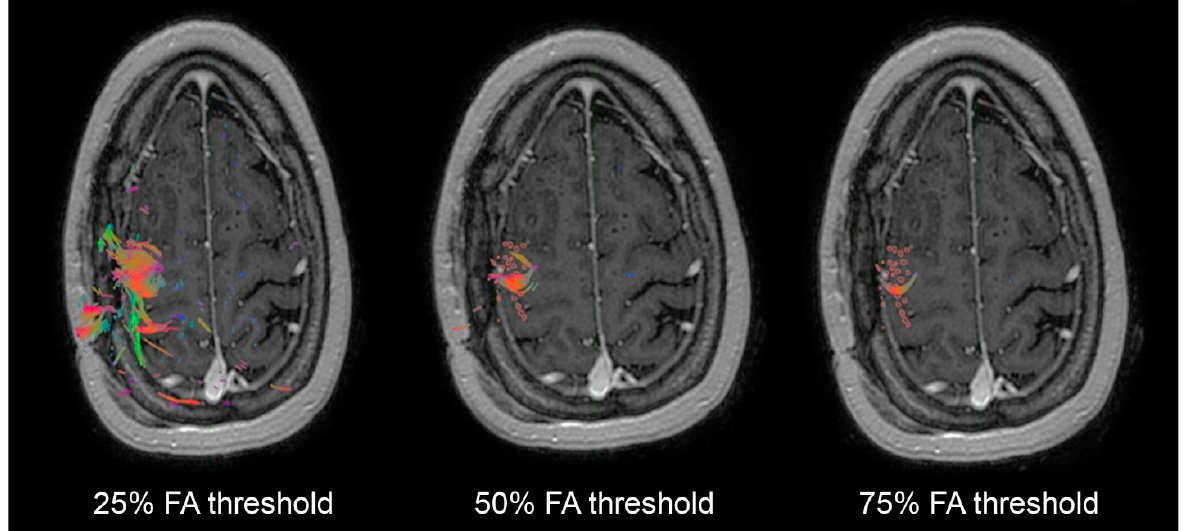
Figure 3. Effect of varying fractional anisotropic (FA) thresholds using TMS as the cortical ROI to generate the corticospinal tract. Left depicts white matter tracks identified by a 25% FA threshold, middle depicts a 50% FA threshold, and right depicts a 75% FA threshold.